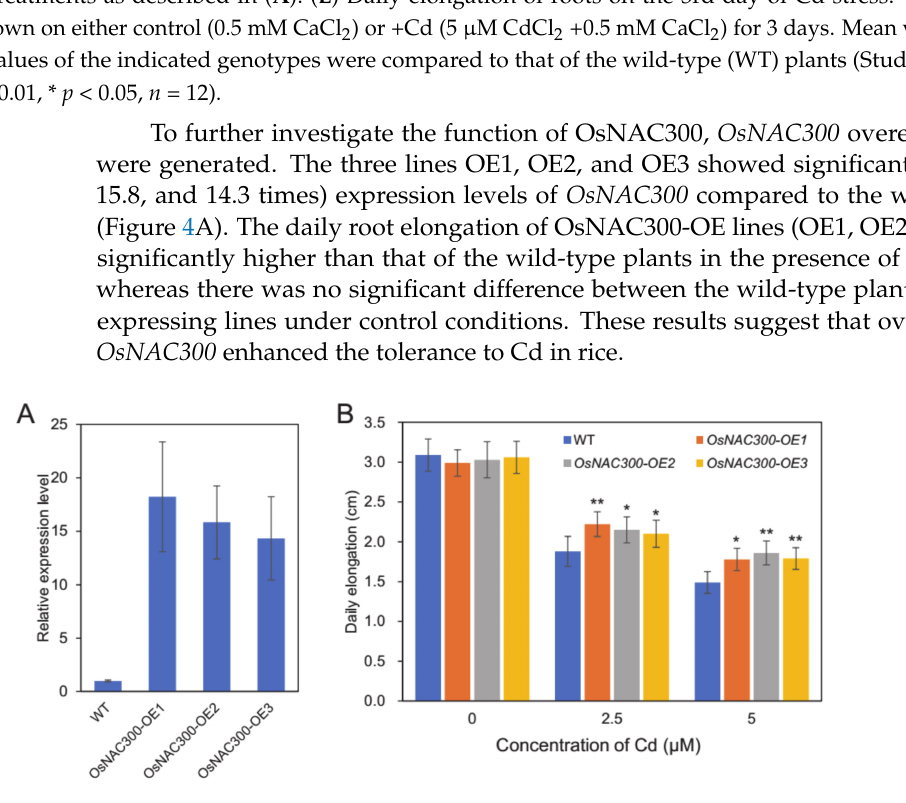
Figure 4. Overexpression of OsNAC300 enhanced the tolerance of rice roots to Cd. ( A ) RT-qPCR analysis of the relative transcription level of OsNAC300 in the roots of the wild-type (WT) and three OsNAC300 overexpression lines. ( B ) Daily elongation of roots on the 3 rd day of Cd stress. 3-d-old rice seedlings were grown on 0, 2.5 or 5 µ M CdCl 2 for 3 days. Mean values ± SD are shown. The values of the indicated genotypes were compared to that of the WT (Student’s t -tests, ** p <0.01, * p < 0.05, n =